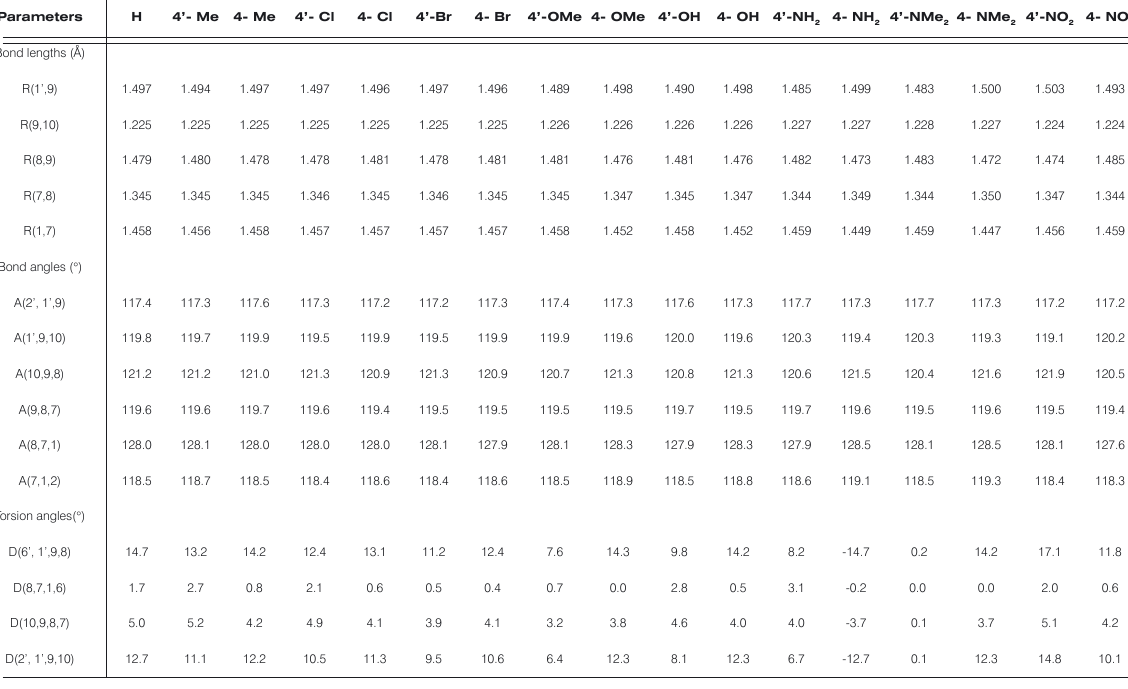
Table 1. Selected key structural parameters of chalcone and its derivatives from the PBE1PBE/6-31G(d) calculations. Parameters